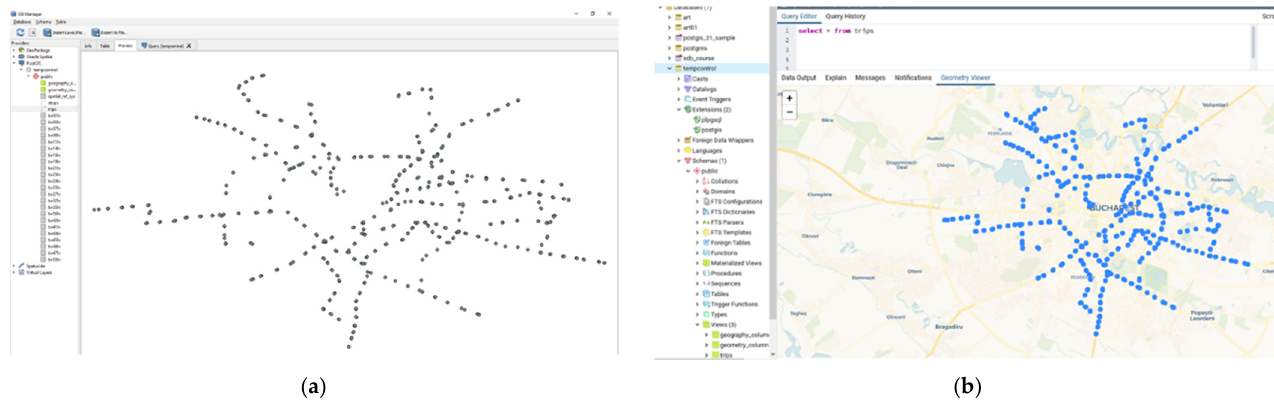
Figure 4. Previewing the vehicle position in stations. ( a ) In DB Manager. ( b ) In pgAdmin using the Geometry Viewer.